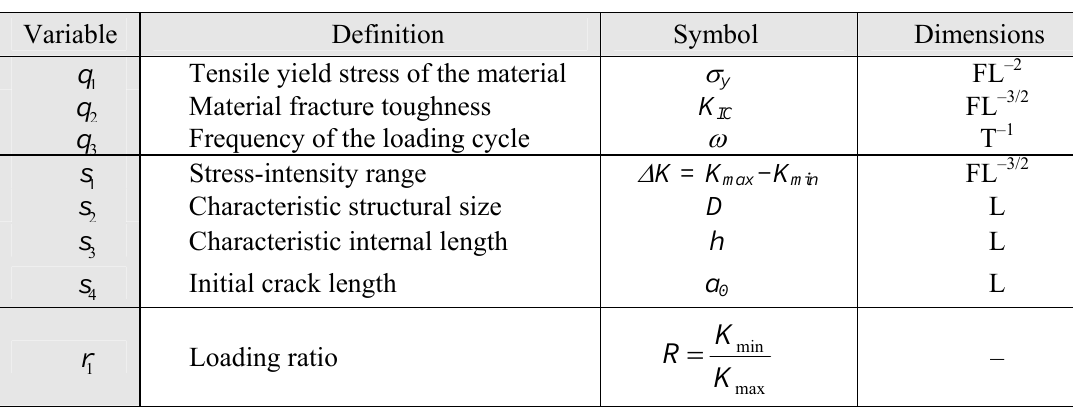
Table 1. Main variables governing the fatigue crack growth